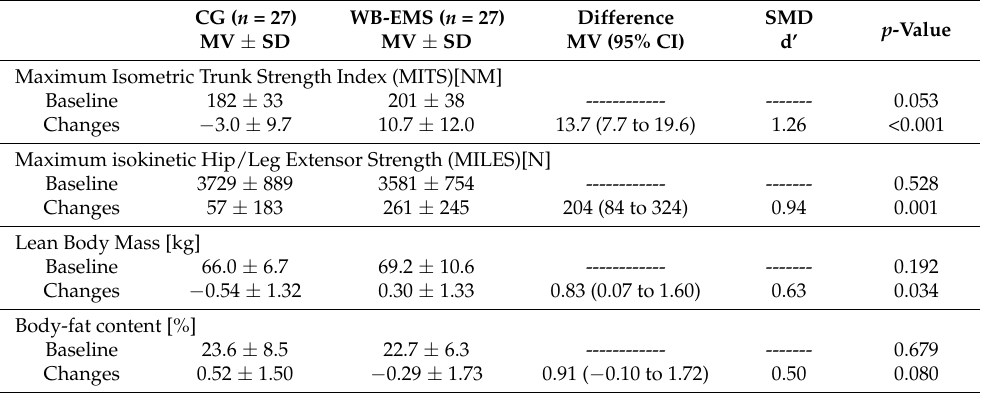
Table 2. Baseline data and changes of primary and secondary outcomes in the WB-EMS and control